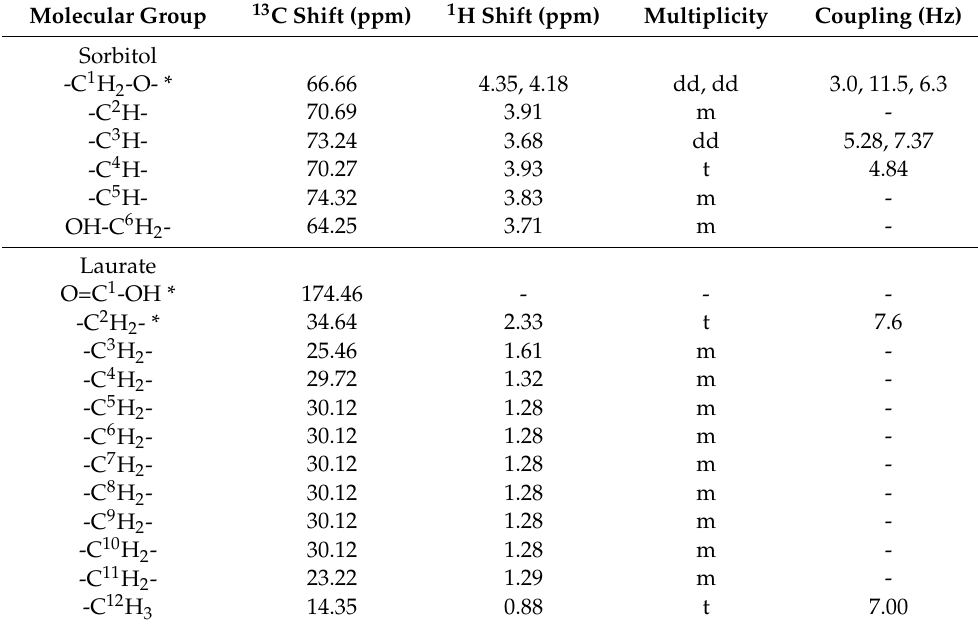
Table 3. 1 H- and 13 C-NMR chemical shifts of sorbitol-6- O -laurate (SL) with their molecular assignments. Molecular